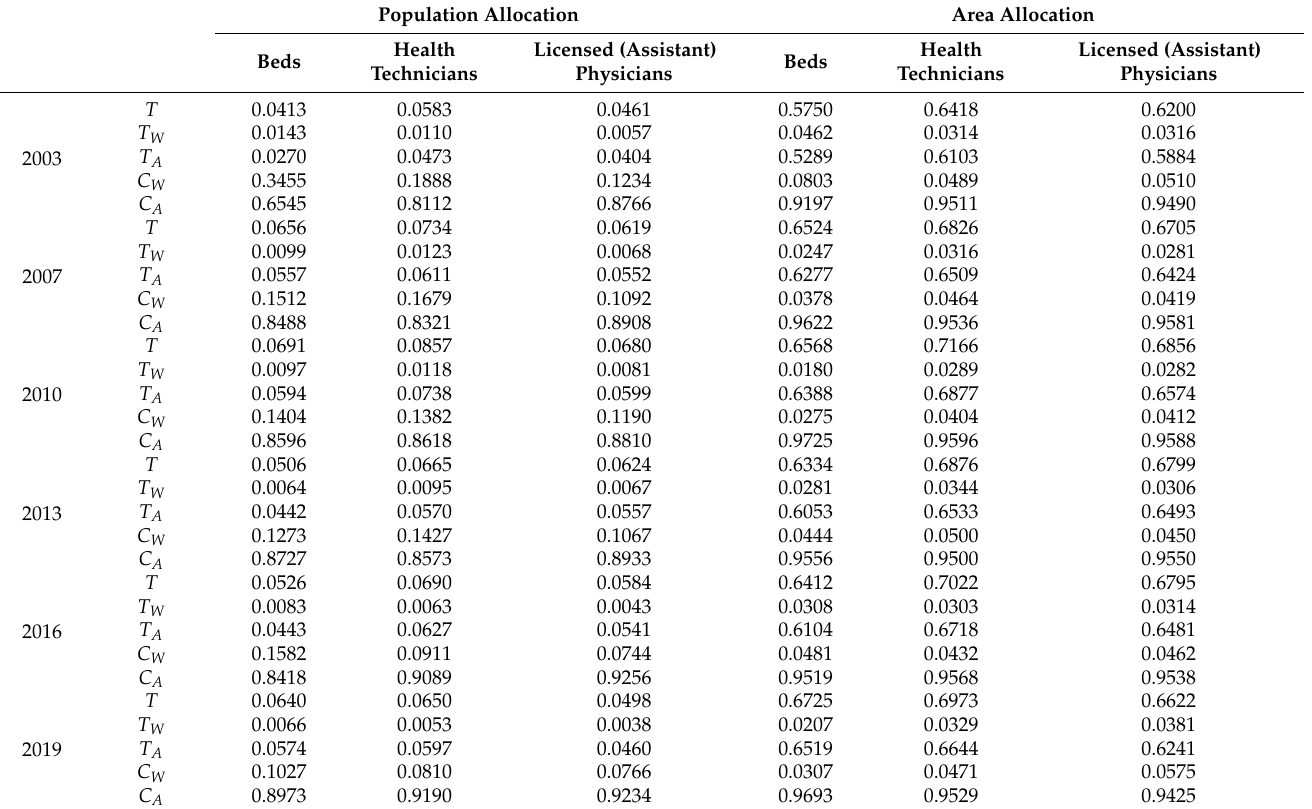
Table 3. Theil index of medical and health resources allocation in Taiyuan,